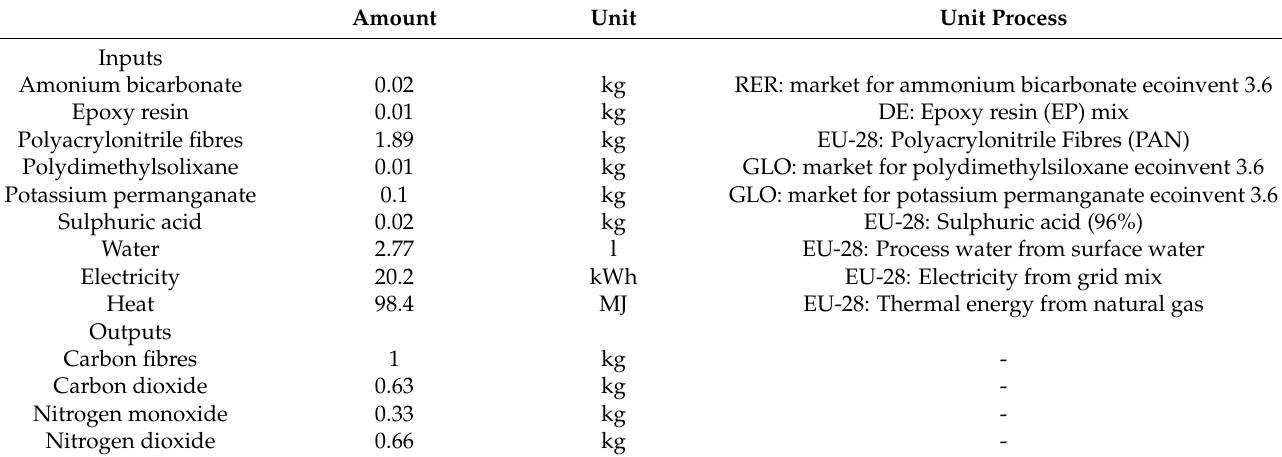
Table 2. Life cycle inventory of the carbon fibre production process